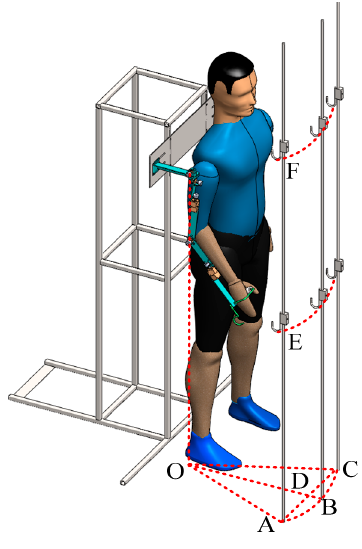
Figure 21. Schematic of the experiment.